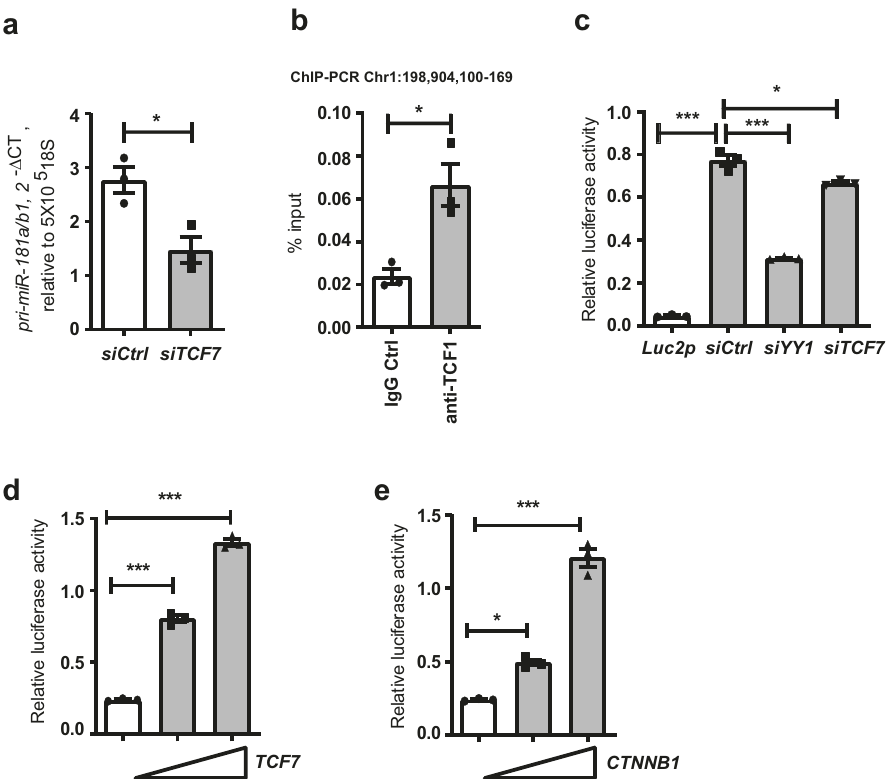
Fig. 1 Regulation of pri-miR-181a/b1 expression by TCF1. a Naive CD4 T cells from young adults were transfected with TCF7 siRNA or control siRNA and assayed for pri-miR-181a/b1 expression after 48 h by q-PCR. Data are shown as mean±SEM ( n = 3). b ChIP assay was performed on naïve CD4 T cells with anti-human TCF1 antibodies, and the sequence representing a previously identi fi ed pri-miR-181a/b1 enhancer region (chr1:198,904,100-169) was ampli fi ed. Precipitation with normal IgG was used as control. Data are shown as mean±SEM ( n = 3). c Sequences corresponding to pri-miR-181a/b1 enhancer region (chr1:198,904,065-558) were cloned into a pGL4.27 [luc2P/minP/ Hygro] plasmid. Dual-luciferase reporter assays were performed in HEK293T cells transfected with TCF7 siRNA, YY1 siRNA, or control siRNA. Data are shown as mean±SEM (n = 3). d , e Increasing amounts (0 ng, 30 ng or 100 ng) of TCF7 (d) and CTNNB1 (e) – containing plasmids were co-transfected with the pri-miR-181a/b1-enhancer-Luc2p reporter construct into HEK293T cells. Reporter activities after 48 h are shown as mean±SEM (n = 3). Comparisons were done by two-tailed paired t test in a , b ; or, by one-way ANOVA with post-hoc Tukey test in c , d , and e . Signi fi cance levels are indicated as * P < 0.05, ** P < 0.005, *** P <